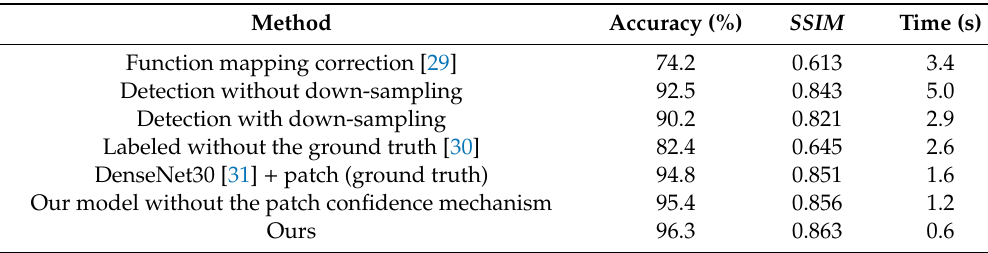
Table 7. Model comparisons were made with the same size and the same frame of the